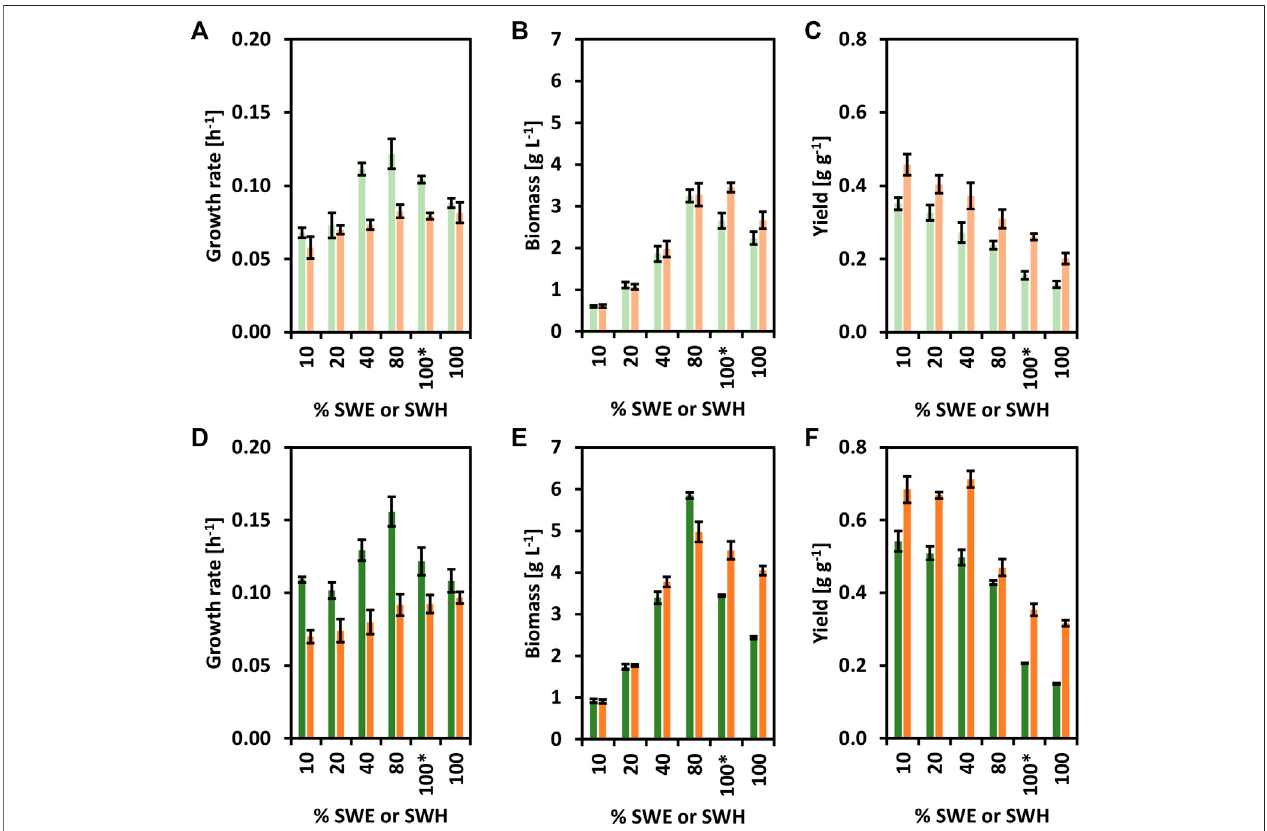
FIGURE4 | Growth ofthe strains CgSW9 and CgSW11 in brown seaweed-based substrates. Concentrations ofSWE or SWH that ranged from 10 to100% were usedascarbon source.Thecondition100*means100%seaweed-basedsubstratesupplementedwithtraceelementsandbiotin. (A) Growthrates(h − 1 )ofCgSW9. (B) Final biomasses formed (g L − 1 ) of CgSW9. (C) Biomass yields (g g − 1 ) of CgSW9. (D) Growth rates (h − 1 ) of CgSW11. (E) Final biomasses formed (g L − 1 ) of CgSW11. (F) Biomass yields (g g − 1 ) of CgSW11. Values from CgSW9 grown on SWE are depicted with light green columns. Values from CgSW9 grown on SWH are depicted with light orange columns. Values from CgSW11 grown on SWE are depicted with dark green columns. Values from CgSW11 grown on SWH are depicted with dark orange columns. Means and standard deviations of triplicates are